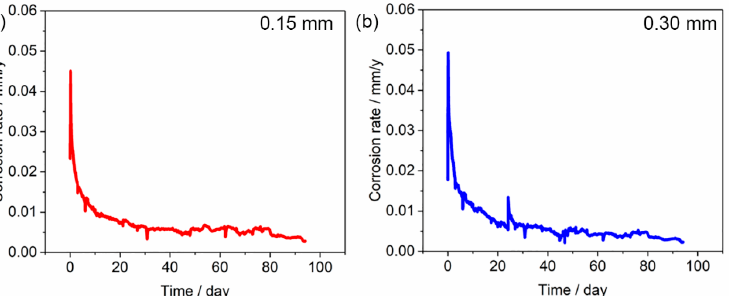
Figure 6. Corrosion rate of coatings tested in 0.5 wt% NaCl and 3.5 wt% (NH 4 ) 2 SO 4 for 3 months. ( a ) 0.15 mm coating sample, ( b ) 0.30 mm coating sample. ( a ) 0.15 mm coating sample, ( b ) 0.30 mm coating sample.